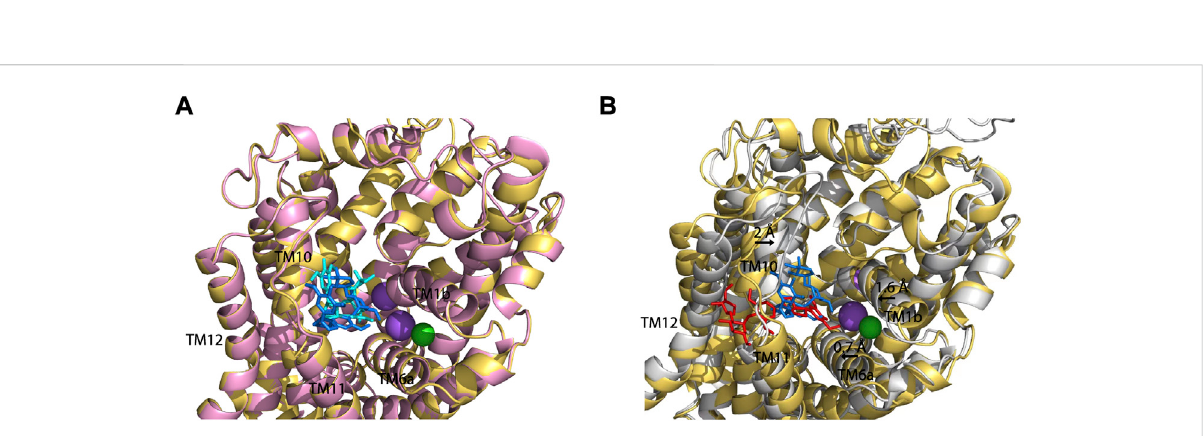
FIGURE 7 Superposition on the allosteric sites of hDAT-SAG, hNET-SAG and hSERT-SAG. (A) Superposition on the allosteric sites of hDAT-SAG ( golden , SAG in blue ) and hNET-SAG ( pink , SAG in cyan ) in outward open states. Na + ( purple ) and Cl − ( green ) ions in the hDAT model were only shown. (B) Superposition on the allosteric sites of hDAT-SAG ( golden , SAG in blue ) and hSERT ( grey , SAG in red ) in outward open states. Na + ( purple ) and Cl − ( green ) ions in the SERT structure were only